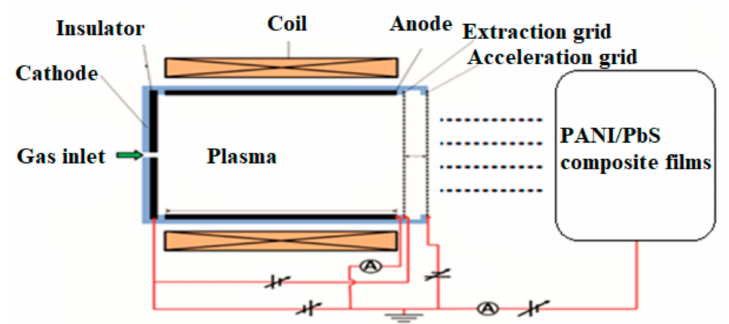
Figure 15. Schematic of a broad-beam ion